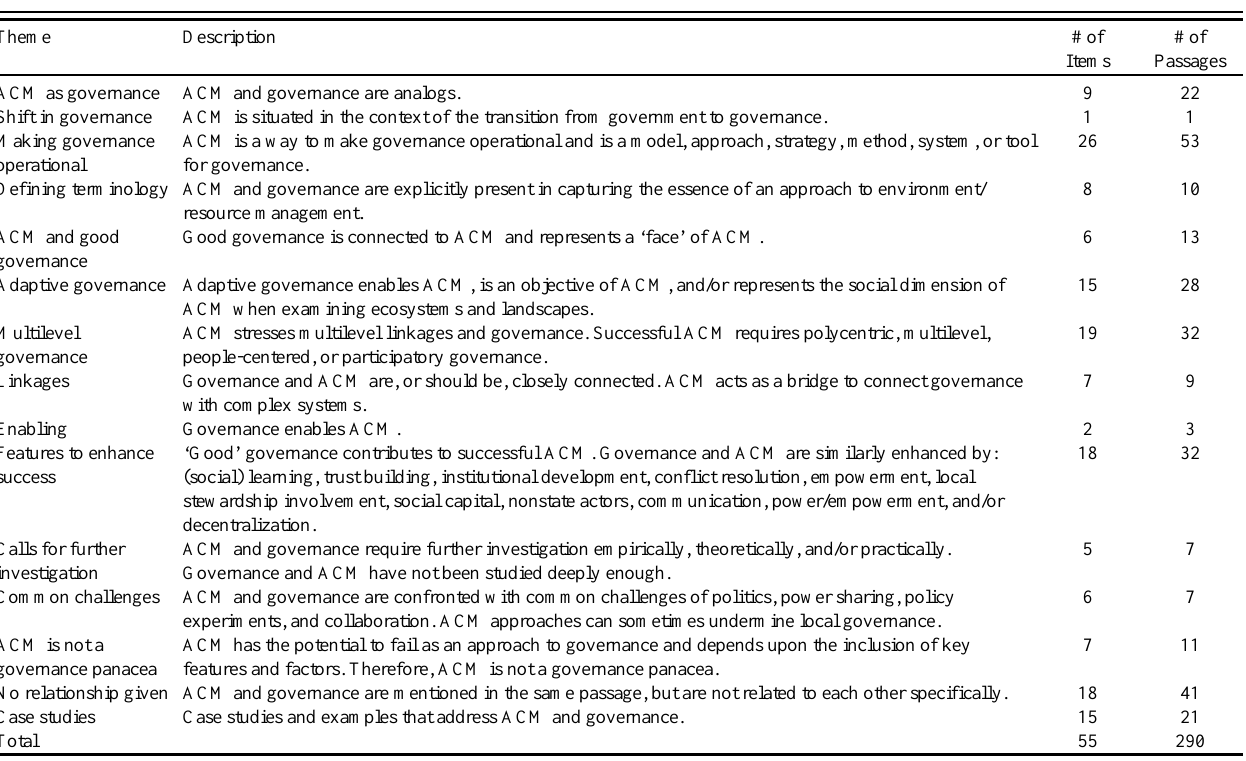
Table 2 . Thematic analysis of passages with the explicit terms governance and ACM.